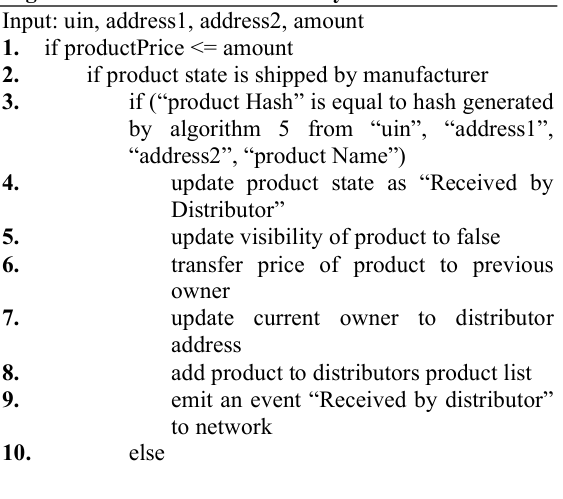
Algorithm 2: Generate UIN of product